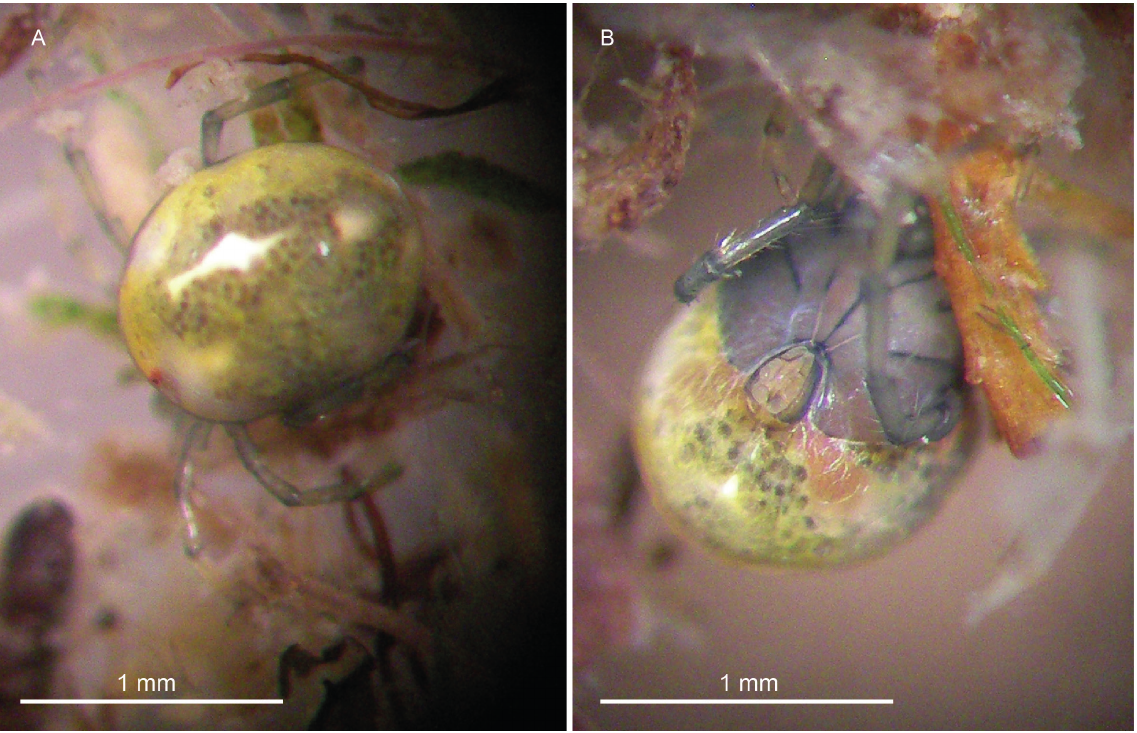
Fig. 1. Lebertia ( Pilolebertia ) porosa Thor, 1900 s. lat. A . Dorsal view. B . Ventral view showing acetabula. Photo: Reinhard